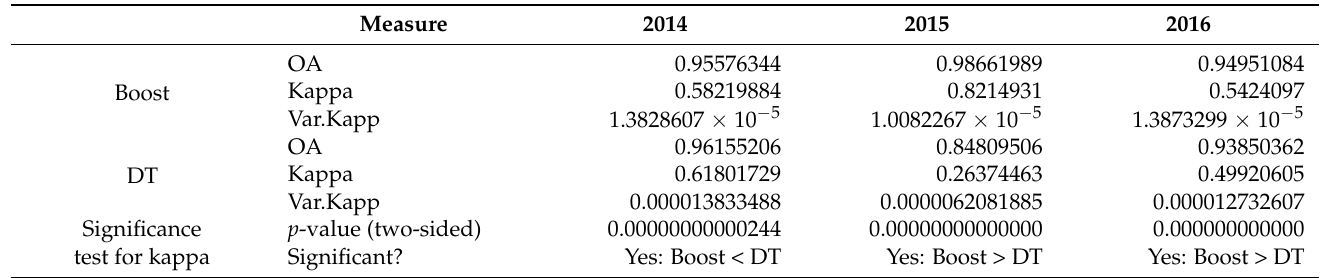
Table 15. Overall Accuracy (OA), kappa coefficient (kappa) and its variance (var.kappa) regarding the classification results depicted in Figures 8–10. Boost was inferior to DT for the 2014 input image but superior regarding the other two